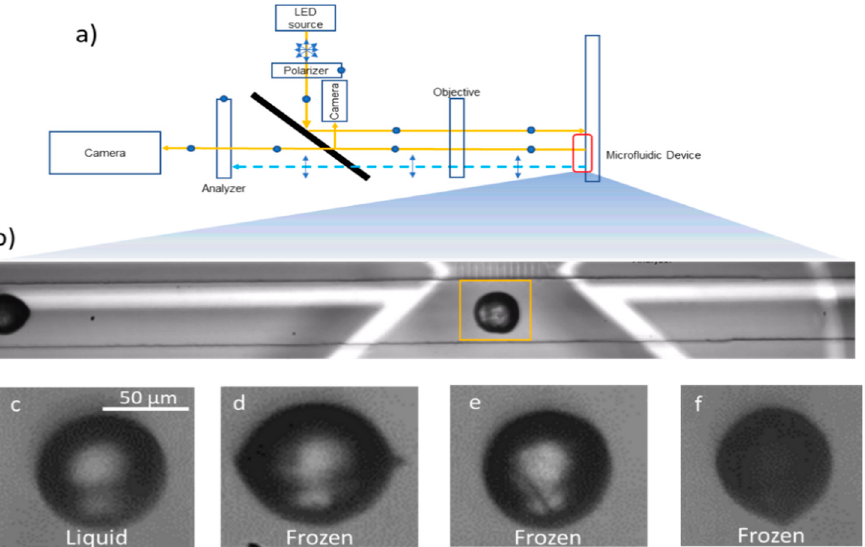
Figure 6. Experimental setup and freezing detection algorithm using a deep neural network: ( a ) Bright-field imaging optical path; ( b ) Region of interest highlighted in yellow inside the flow chan- nel; ( c – f ) Liquid and different frozen droplets as they appear in bright field images.